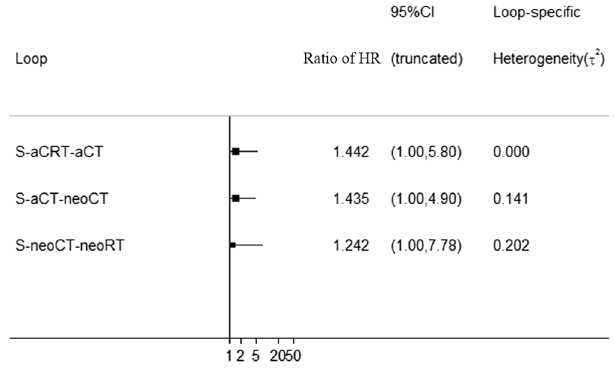
Figure 4. Inconsistency test chart.